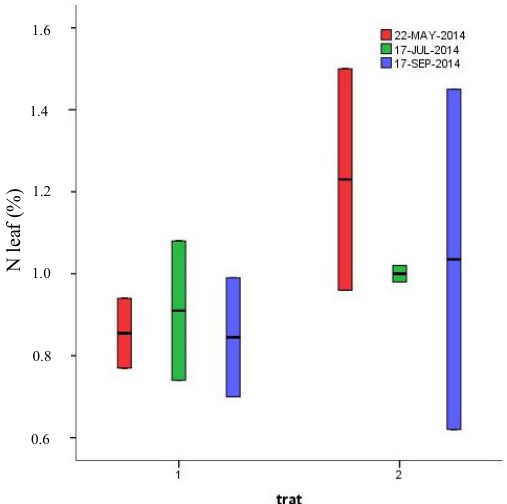
Figure 2. Nitrogen leaf content, expressed in %, for both treatments (trat 1: 100% and trat 2: 60% of the dose) for three harvests (represented by the date of cutting). Nutrient contents in leaves (Table 2) remain relatively stable, although decreasing slightly over